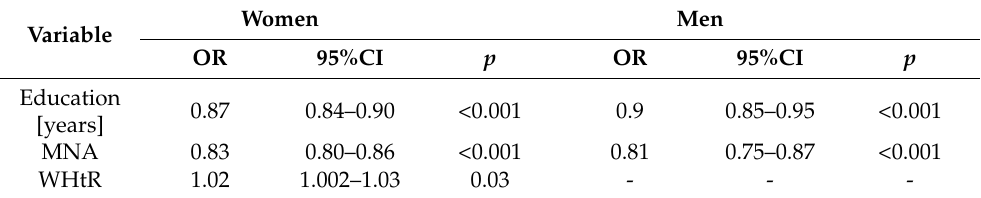
Table 4. Odds ratios (95% confidence interval) for the risk of belonging to the group with higher score of depression symptoms (GDS > 5) for education years, MNA score, and WHtR.